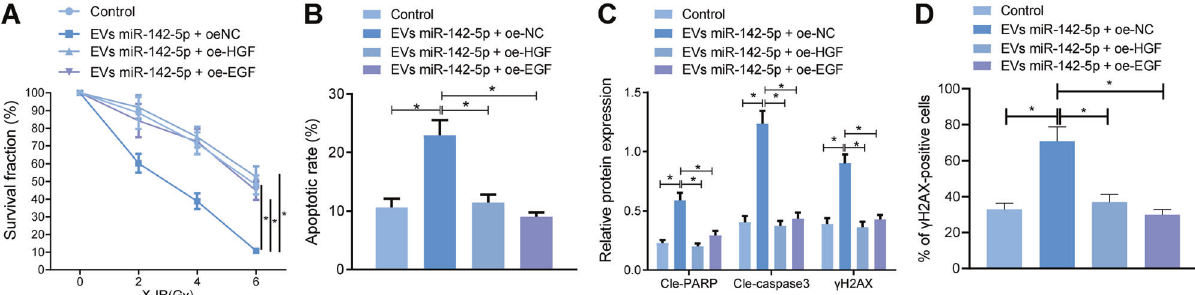
Fig. 6 EVs-miR-142-5p enhances radiosensitivity of radiotherapy-resistant NPC cells by inactivating HGF/c-Met and EGF/EGFR pathways. A Colony formation assay to detect the survival rate of 5-8FR cells in each group after 6 Gy radiotherapy. B The apoptosis rate of 5-8FR cells detected by fl ow cytometry. C Western blot to detect the expression of PARP, Caspase-3, and γ H2AX in 5-8FR cells after 6 Gy radiotherapy. D The expression of γ H2AX protein in 5-8FR cells detected by immuno fl uorescence staining. * p < 0.05. All experiments were repeated three